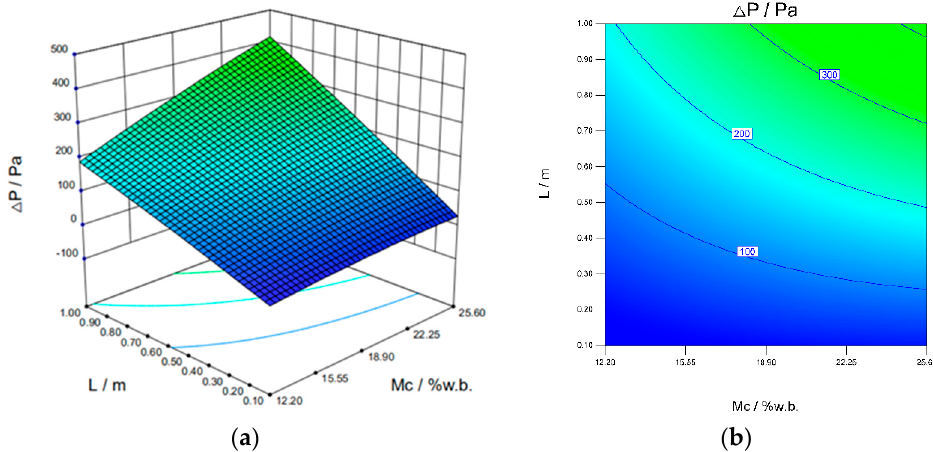
Figure 5. The interaction of Mc and L on the Δ p ( a ) and the contour plots ( b ).